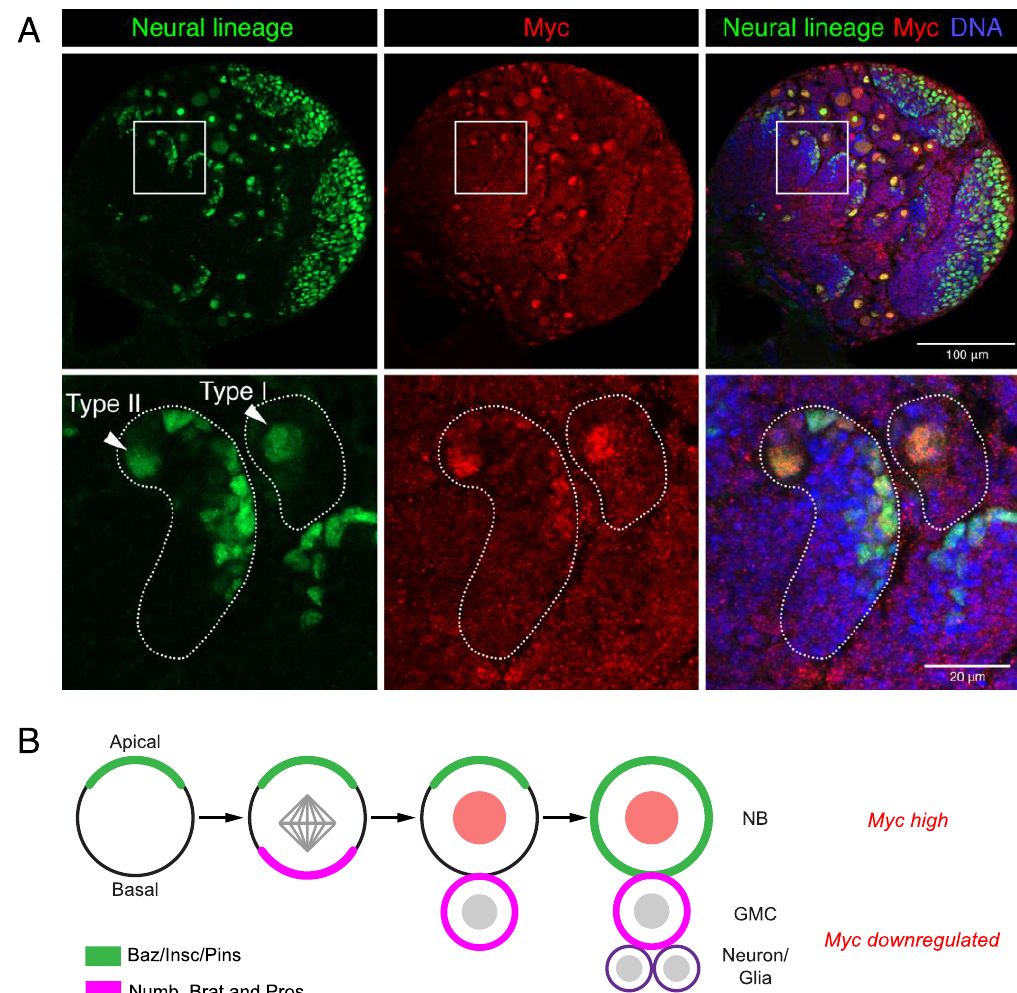
Figure 3. Myc promotes Drosophila neural stem cell renewal. ( A ) Myc is high in neural stem cells in the larval brain (neural lineage marked with Deadpan, green). Type I neuroblasts (NB) directly produce ganglion mother cell (GMC) progenitors, while Type II produce GMCs via a transit-amplifying intermediate progenitor lineage. ( B ) Neuroblasts divide asymmetrically in order to self-renew and generate progenitors. Apical and basal factors are asymmetrically distributed during mitosis in order to specify the stem and progenitor cell fate of the daughters.